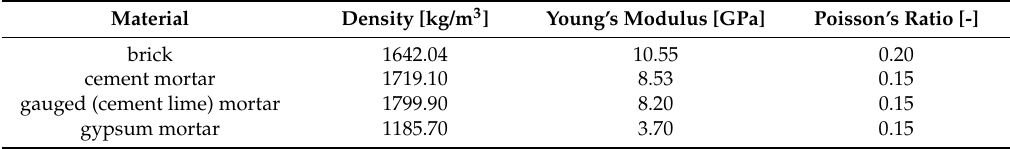
Table 1. Mechanical properties of the bricks and mortar used for the test specimens.